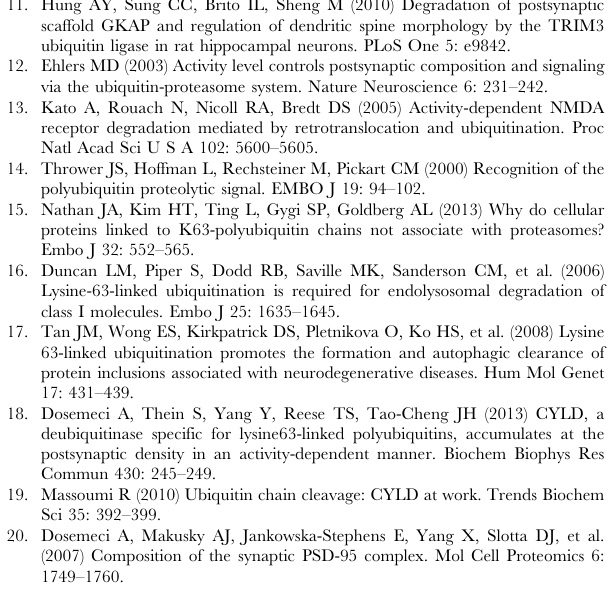
Table S1 Percent label intensity at the PSD compared to controls. In one EM experiment, sister hippocampal cultures were treated with either NMDA alone or NMDA plus APV (50 m M) for 2 min and labeled for either CYLD or CaMKII, followed by the quantification of immubolabeling intensities at the PSD. The differences between NMDA and NMDA + APV groups were statistically significant for both proteins ( P , 0.005, ANOVA with Tukey